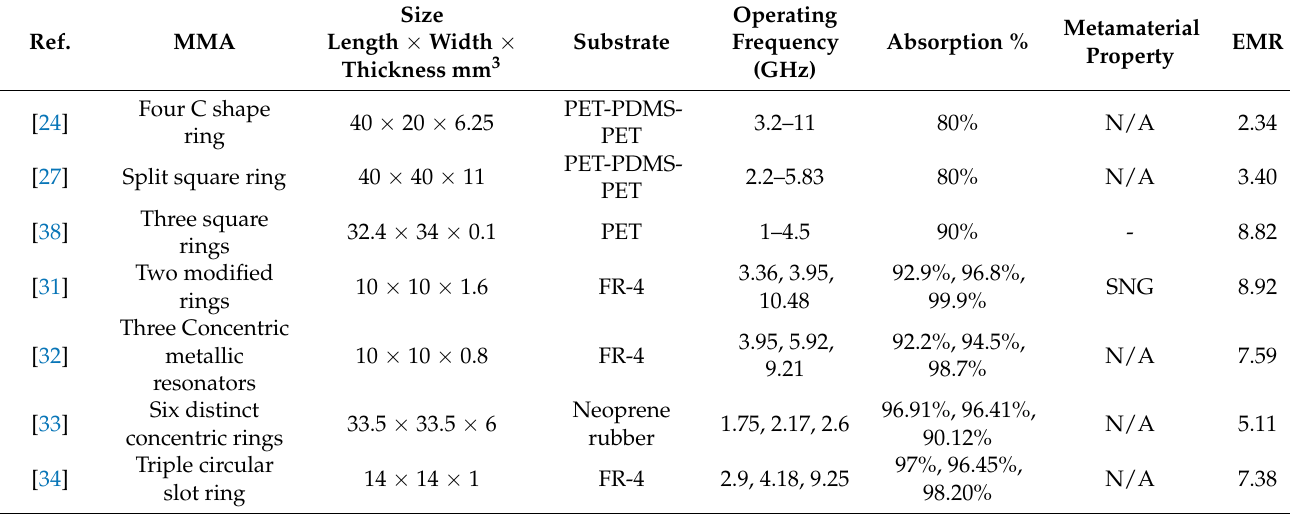
Table 5. Comparisons with existing MMAs.